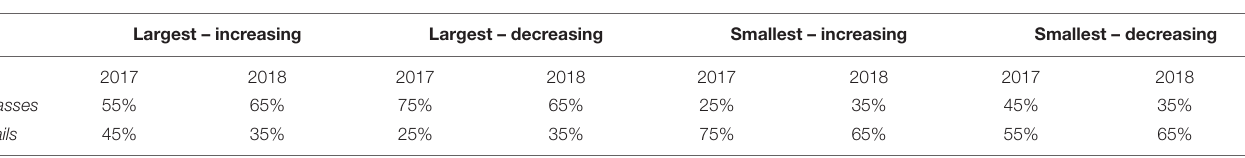
FIGURE 2 | Screenshot of an asymmetrical scenario (taken from experiment 2). Translation: Driving School Tempo keep tabs of how many pupils pass and fail their first exam. At the end of 2017 and 2018, the following percentages were given: [..]. How would you prefer to describe this development? TABLE 1 | Four versions of the distribution used in Figure 2 .